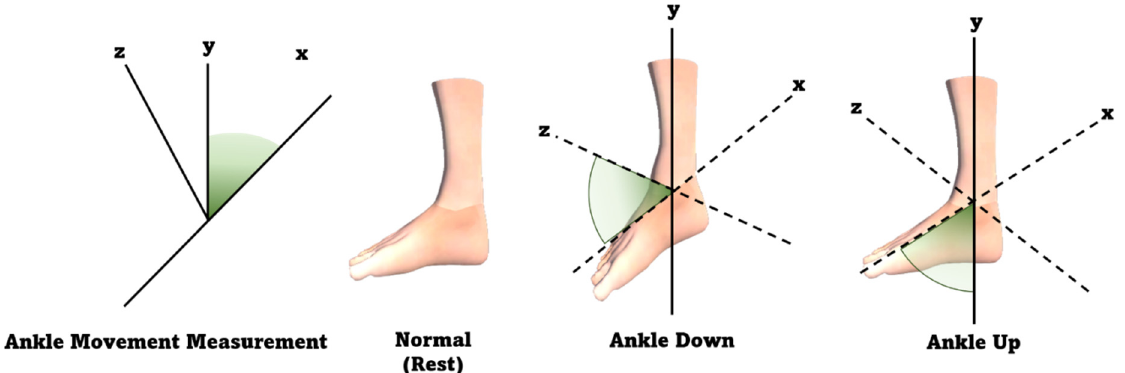
Figure 5. Rehabilitation Behavior Assignment.